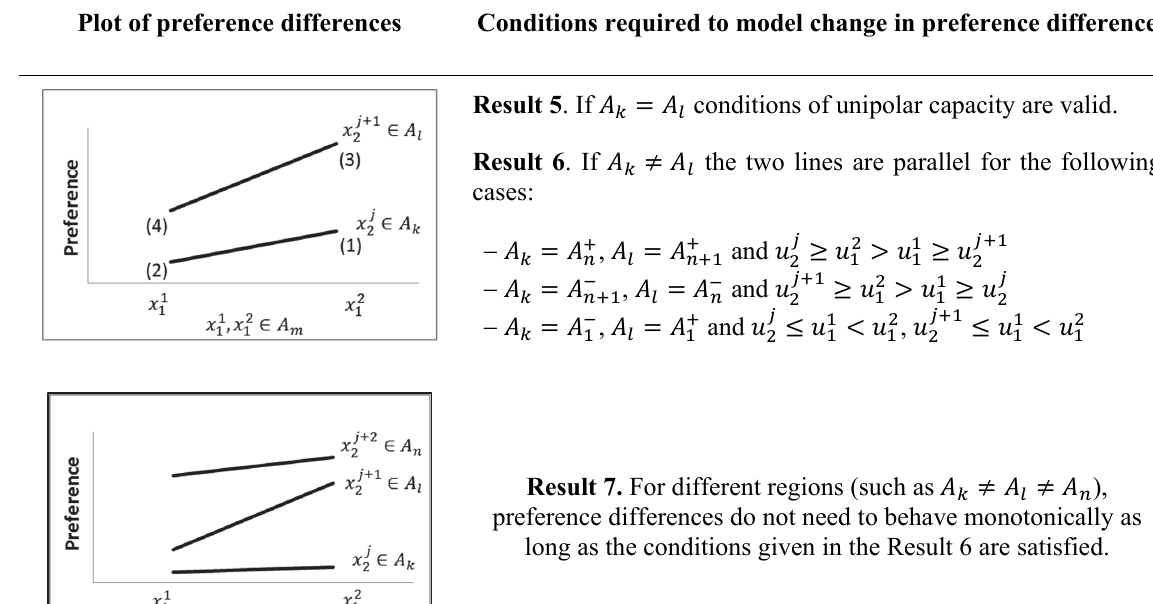
Conditions required to model change in preference difference by k-ary capacity Plot of preference differences